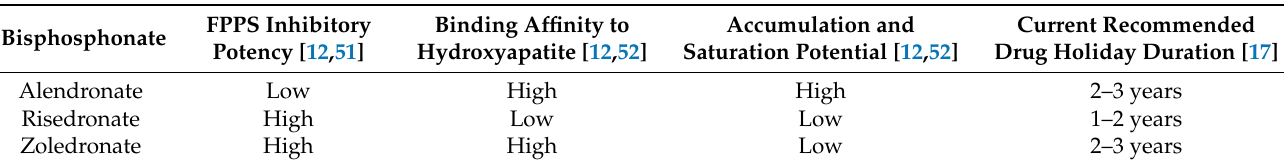
Table 1. Pharmacologic Properties and Current Drug Holiday Duration Recommendations for the Most Commonly Used